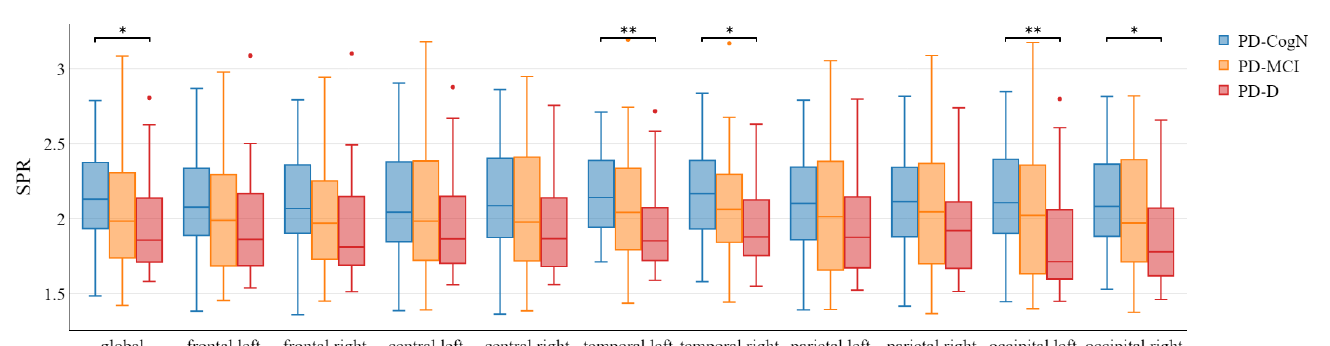
Figure 5. Spectral PowerRatio in the different areas between patient’s groups with statistical signifi- cance highlighted (* p < 0.05, ** p <